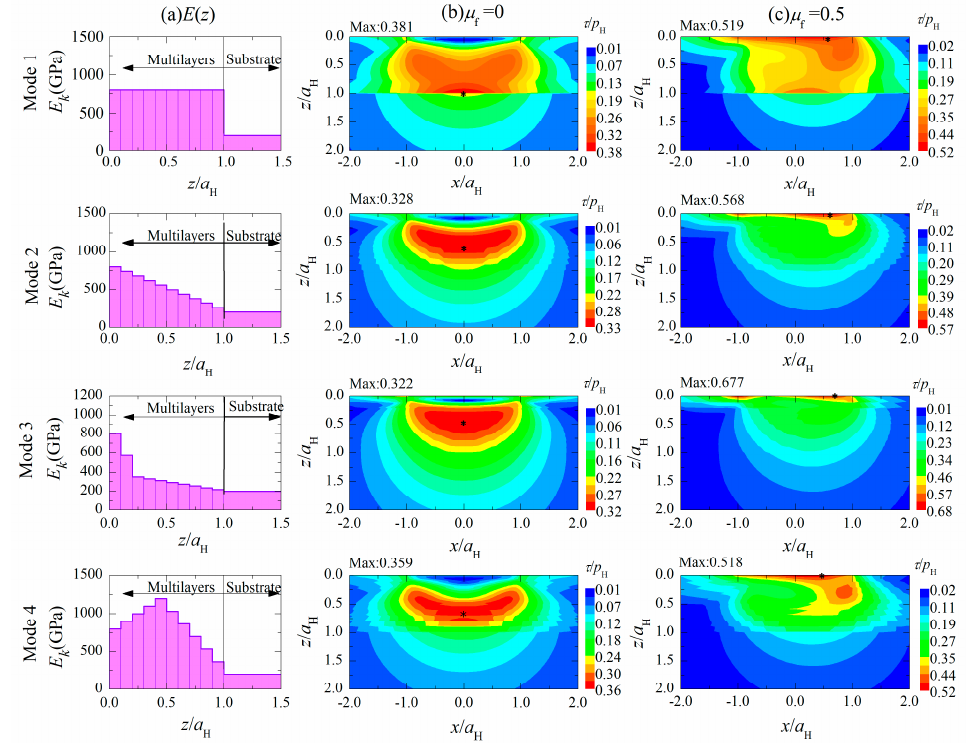
Figure 4. The maximum shear stress τ / p H in x - o - z plane of multilayered coatings with di ff erent elasticity modulus changing modes under various friction coe ffi cients, ( a ) elasticity modulus changing mode, ( b ) maximum shear stress for µ f = 0, ( c ) maximum shear stress for µ f = 0.5.